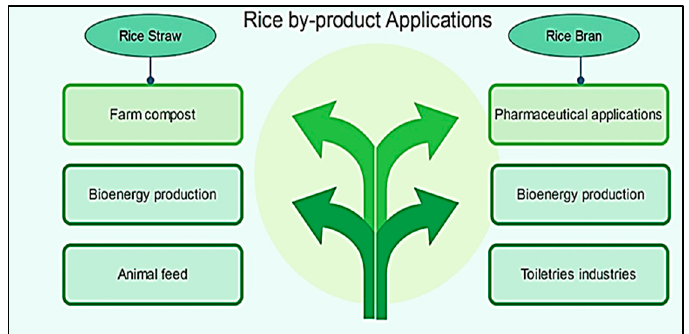
Figure 5. Some rice by-product applications.